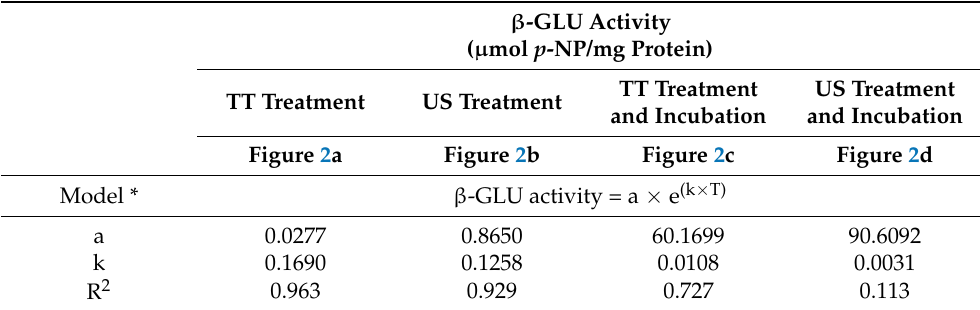
Table 3. Parameter estimates of the exponential curve for β -glucosidase ( β -GLU) activity as a function of